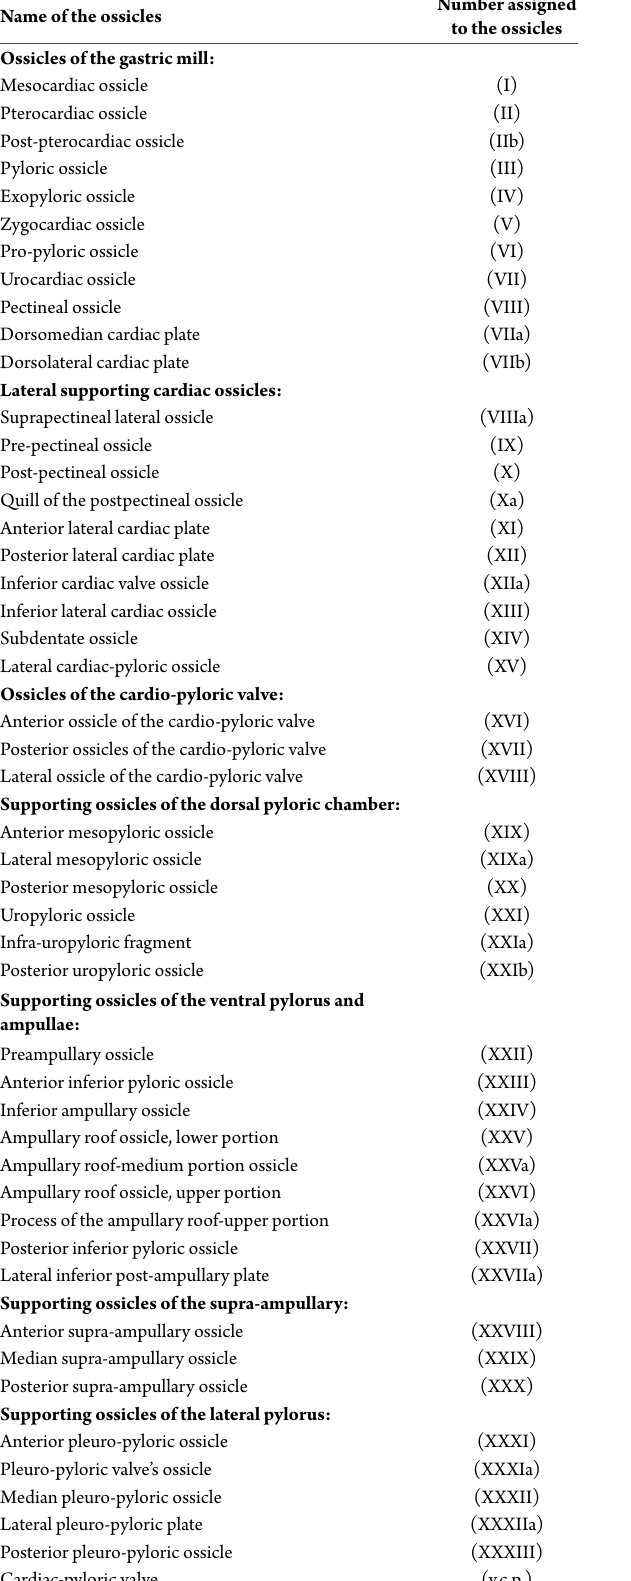
Table 2. Nomenclature and abbreviations used in the morphological descriptions ossicles of the stomachs of four species of